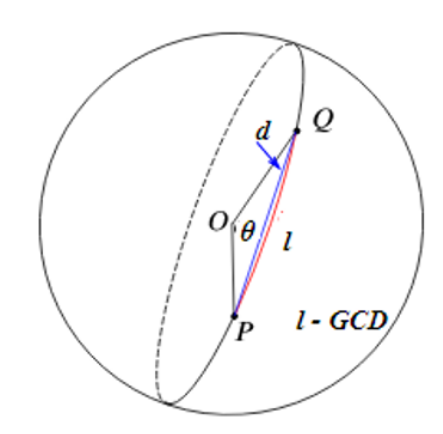
Figure 1 Great Circle